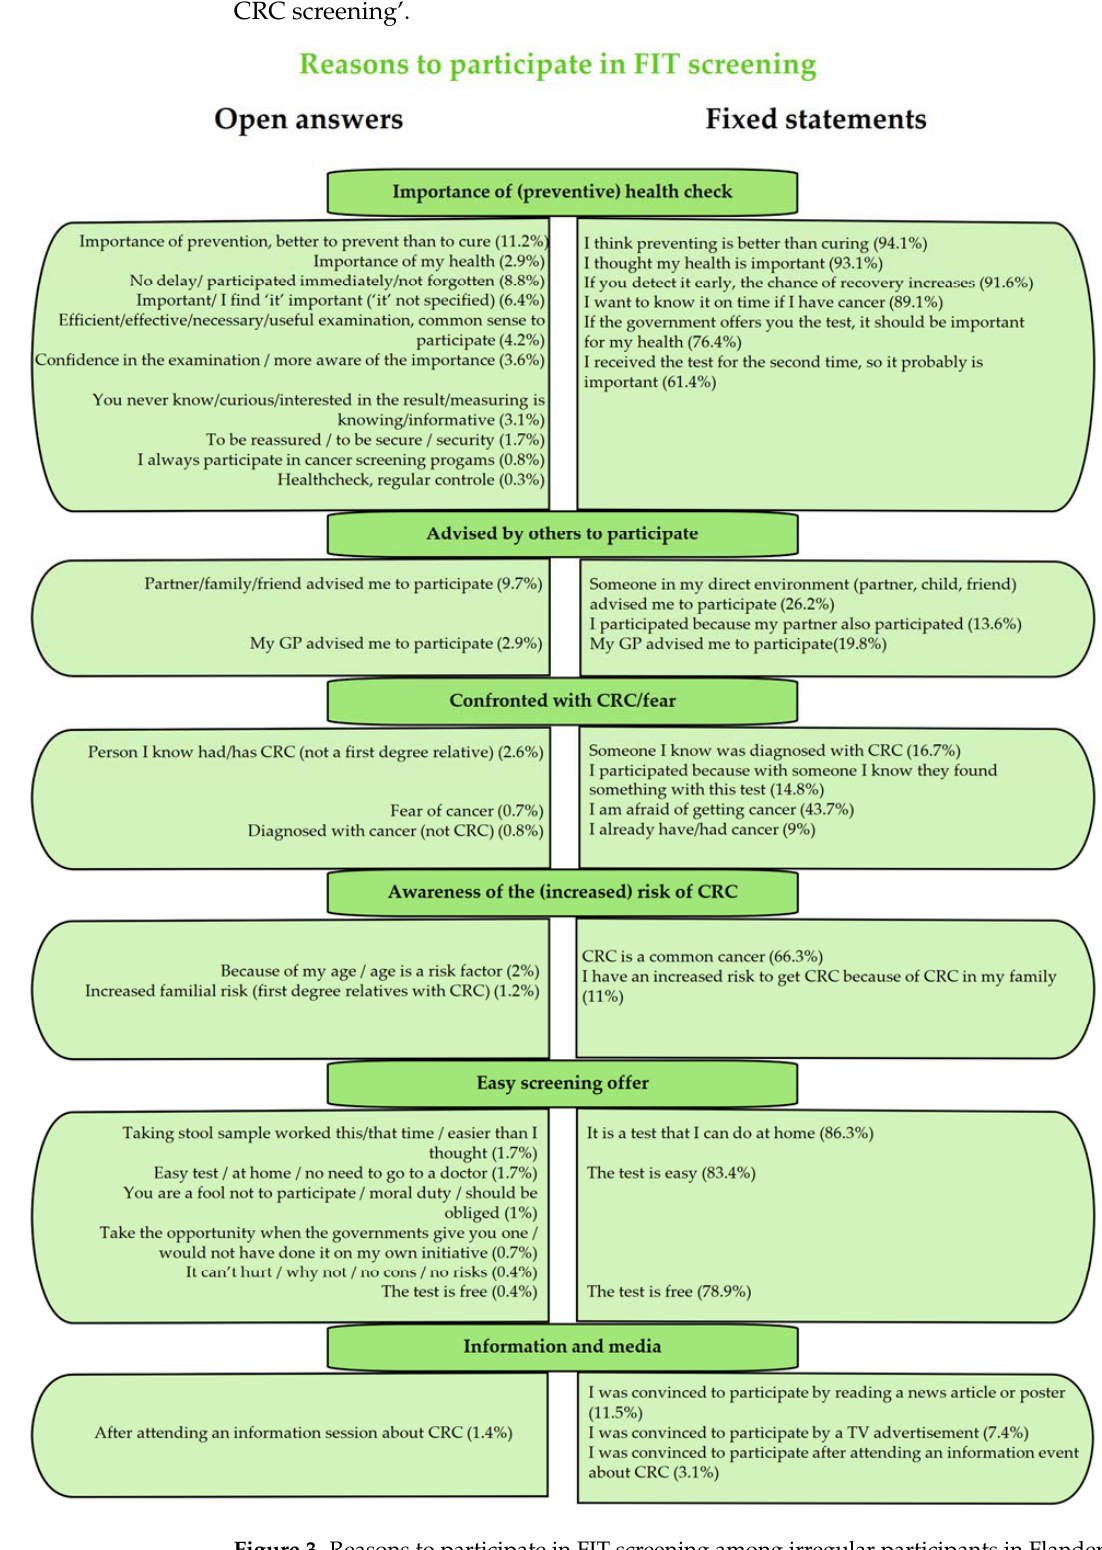
Figure 3. Reasons to participate in FIT screening among irregular participants in Flanders which are common between individuals’ self-reported open answers and given fixed statements (only delayed entries N = 3401) (Q2 and S2). GP: general practitioner.